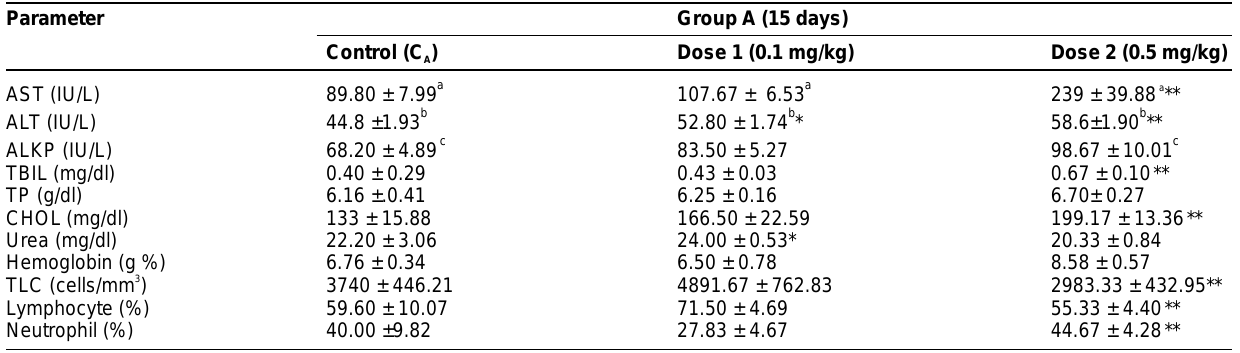
Table-1. Changes in the blood profiles of control and deltamethrin-exposed Swiss albino mice group with 15 days exposure (n = 17). Parameter